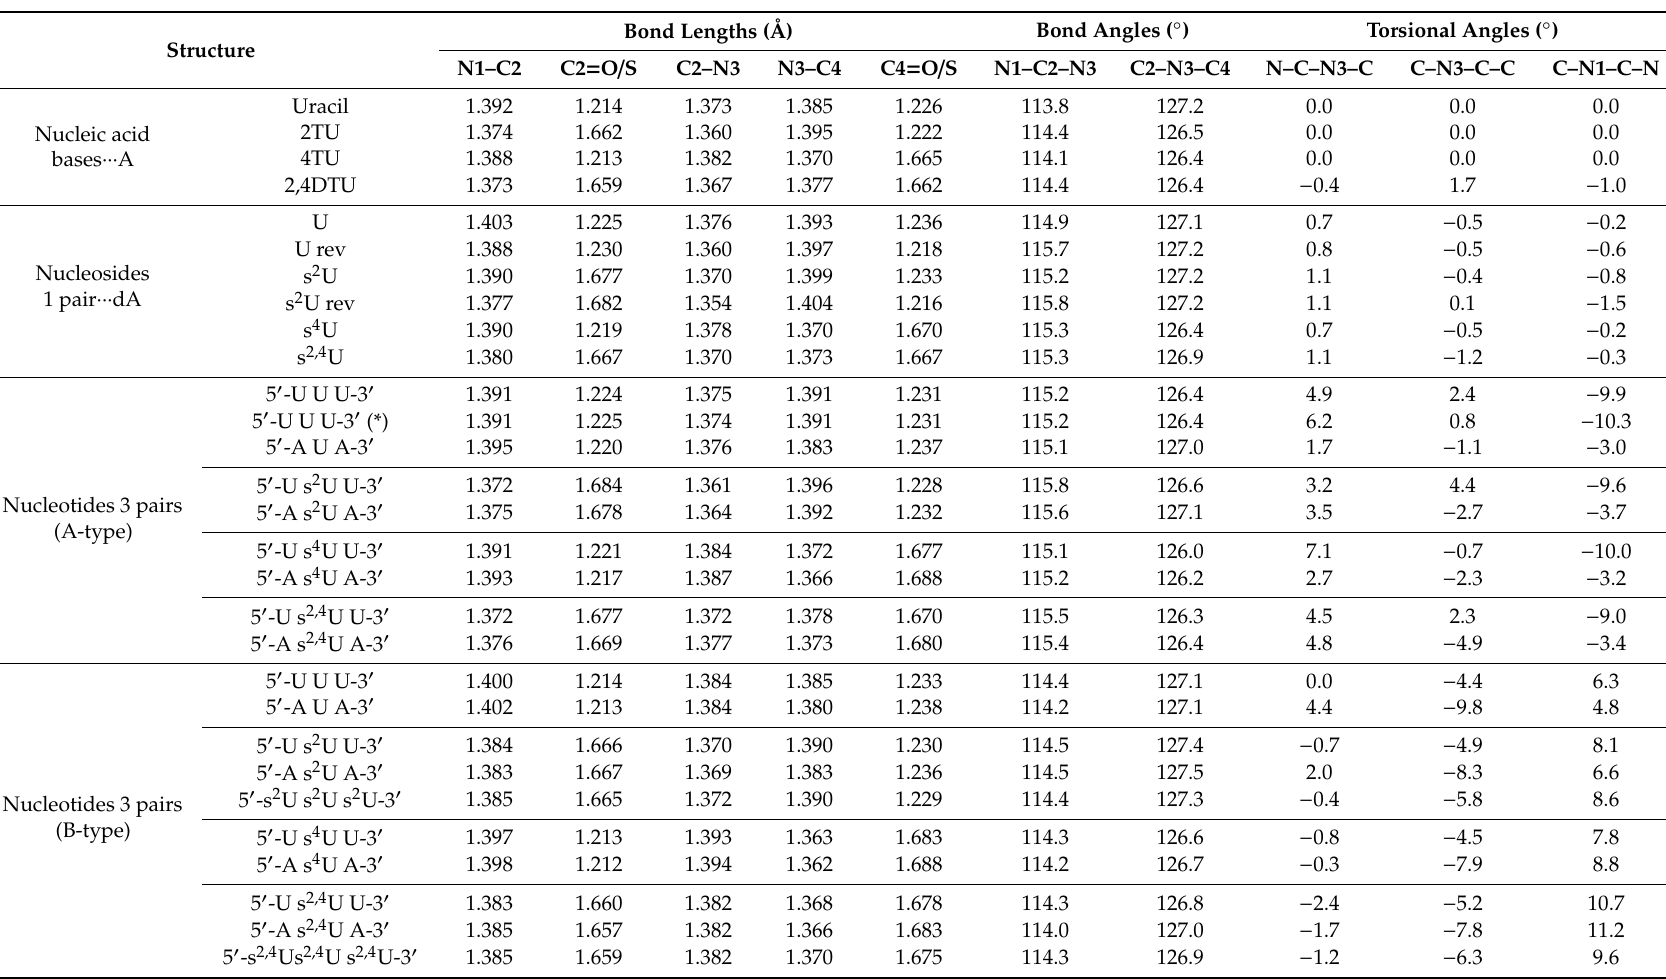
Table 6. Several selected optimized geometric parameters of the uracil ring calculated at the M062X / 6-31G(d,p) level in the nucleic acid base pairs with adenine (A), in the nucleoside base pairs with 2 (cid:48) -deoxyadenosine (dA), and in the microhelixes of three nucleotide base pairs with dA / dG (2 (cid:48)